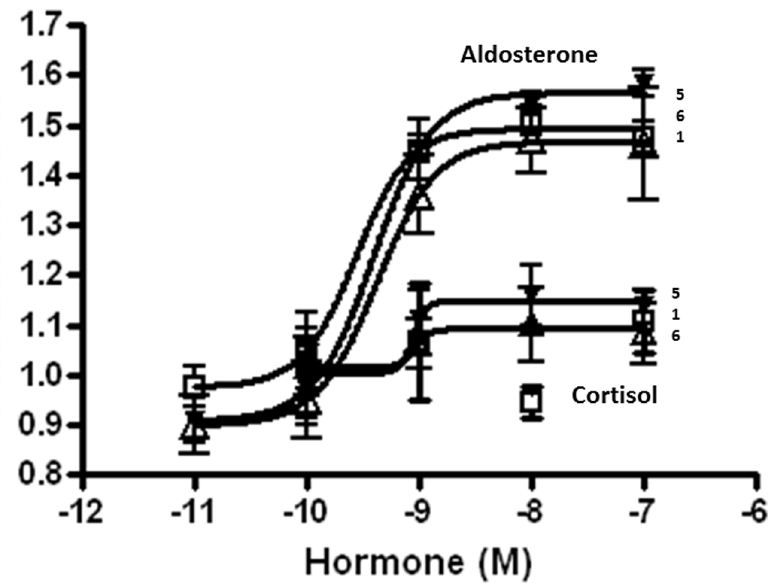
Figure 2. Effect of mineralocorticoid receptor (MR) and aldosterone in HEK293T cells expressing Kcnn4 genomic clone. Regions of the Kcnn4 genes showing positive response in a ChIP assay and indicated by bars in Figure-1C (clone-1, clone-3, clone-5, clone-6, clone-7 and clone-8) were sub-cloned in pGL4.23 and tested for the presence of MR/aldosterone (mineralocorticoid)-responsive enhancers (MRE). The HEK293T cells were transfected with pGL4.23 or pGL4.23 containing Kcnn4 genomic clones. The cells transfected with Kcnn4 genomic clones were also transfected with MR. Luciferase activity was measured in the cells transfected with the Kcnn4 genomic clones with ( hatched bars ) and without ( grey bars ) MR transfection. The luciferase activity in the cells transfected with the Kcnn4 genomic clones and MR was also measured in the presence of 10 nM aldosterone ( black bars ). For clarity, luciferase activity measured in the presence of a plasmid, MR and aldosterone are shown in cells transfected with pGL-4.23, clones-3, -5 and -6. Results presented represent mean 6 SE from 3 different experiments. * p , 0.05– compared to